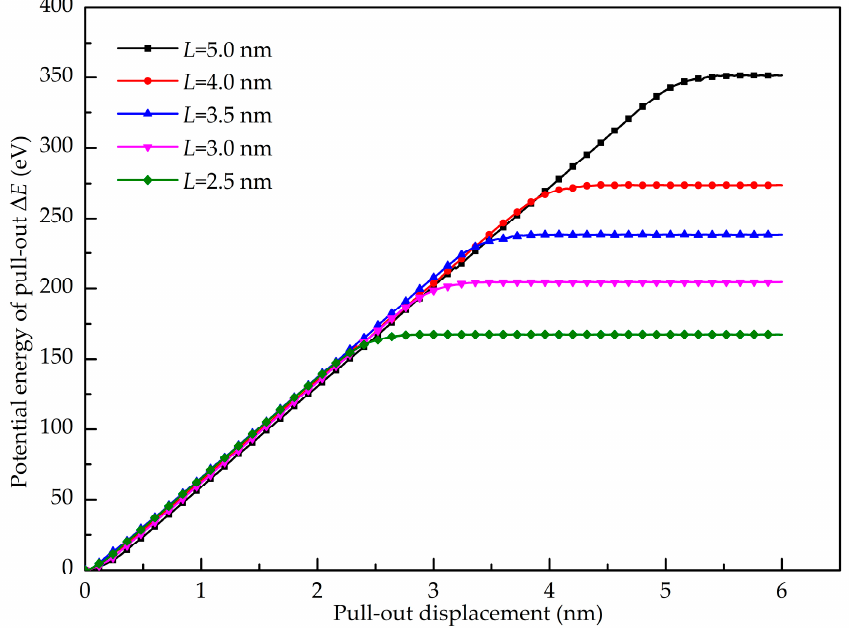
Figure 14. Potential energy increment during pull-out test with different embedded length of graphene.